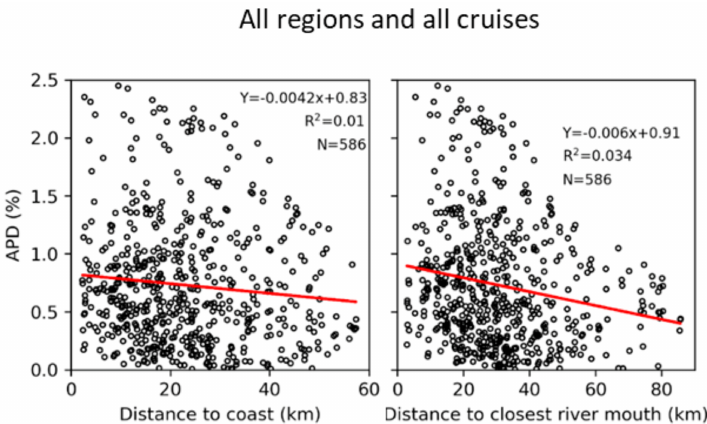
Figure 7. Correlation between the APD values of each matchup and the respective distance to the coast and the closest